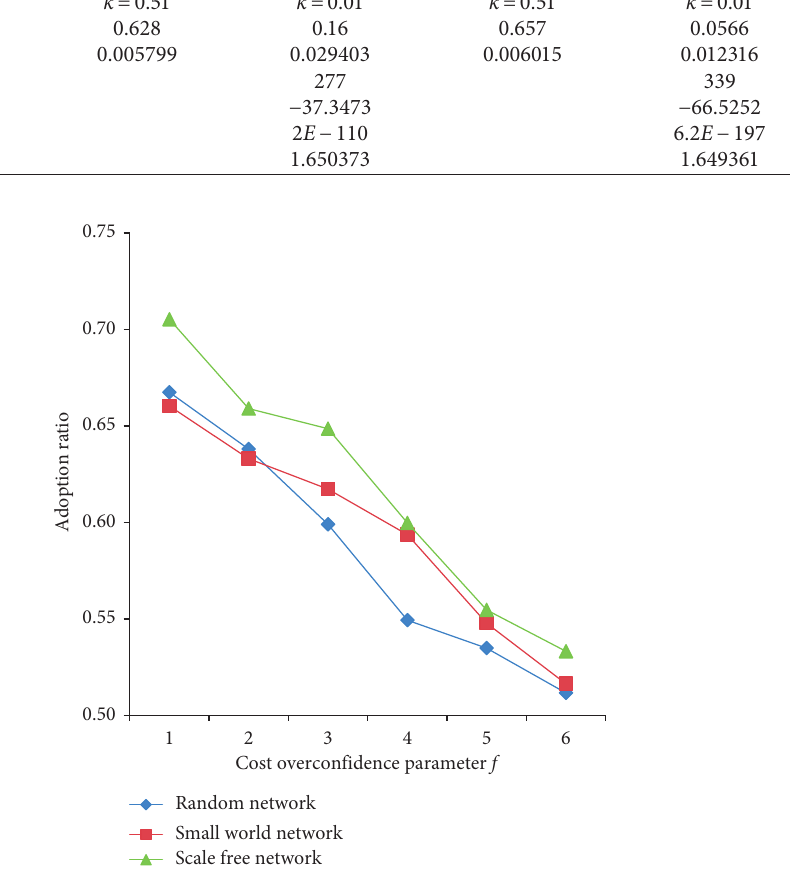
Figure 18: Effect of cost overconfidence on product diffusion under different networks. Table 5: The t -test results of samples.